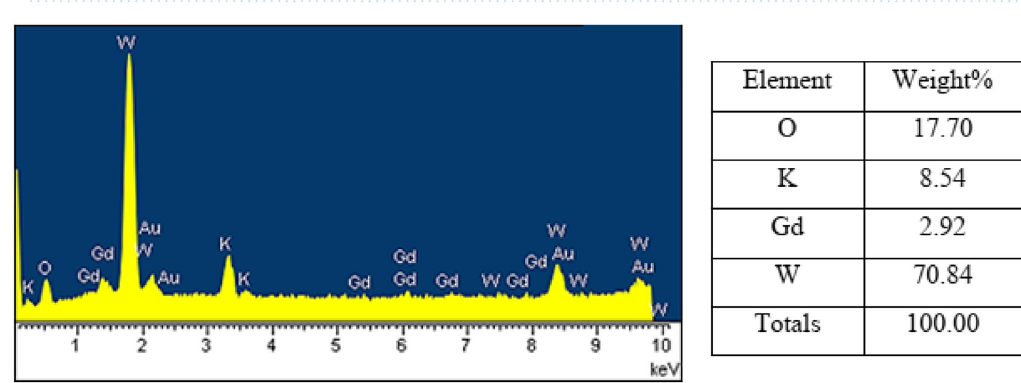
Figure 7. SEM images of nano-Gd-B 2 W 22 .